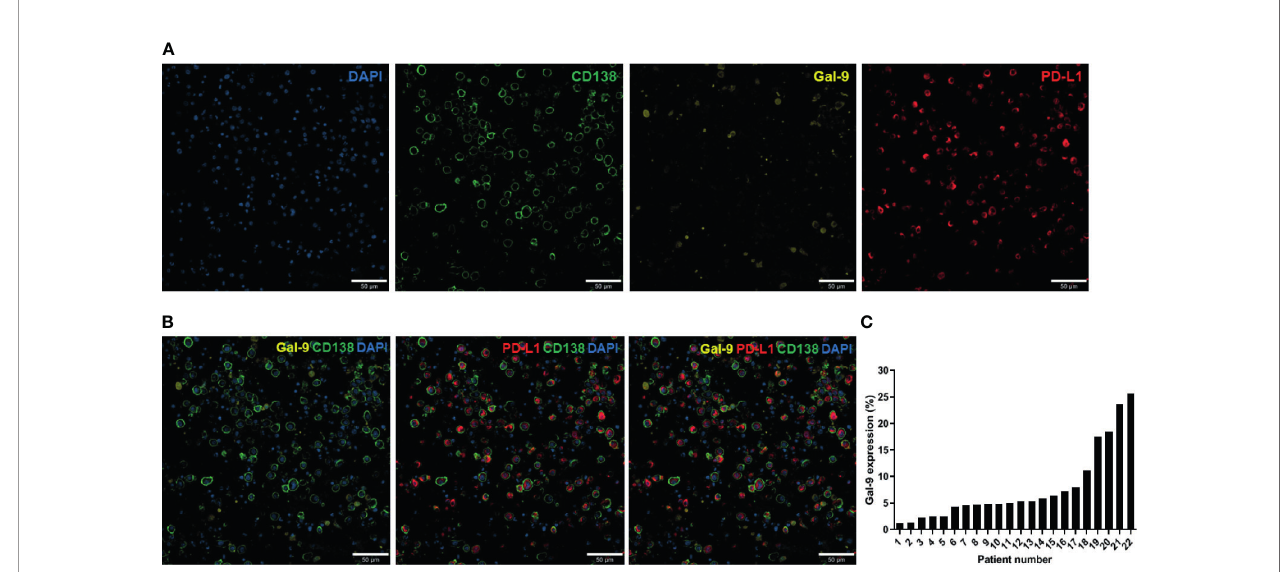
FIGURE 1 | Immuno fl uorescence analysis of Gal-9 and PD-L1 expression in bone marrow plasma cells from patients with multiple myeloma. (A) Confocal images of 4 – 5-µm-thick formalin- fi xed, paraf fi n-embedded bone marrow aspirate specimens (clot sections) obtained from patients with myeloma. The sections were stained for CD138, Gal-9, and PD-L1. Original magni fi cation, 200×. (B) Representative merged images of Gal-9, PD-L1, and CD138 staining are shown. (C) Distribution of Gal- 9 expression in patients with multiple